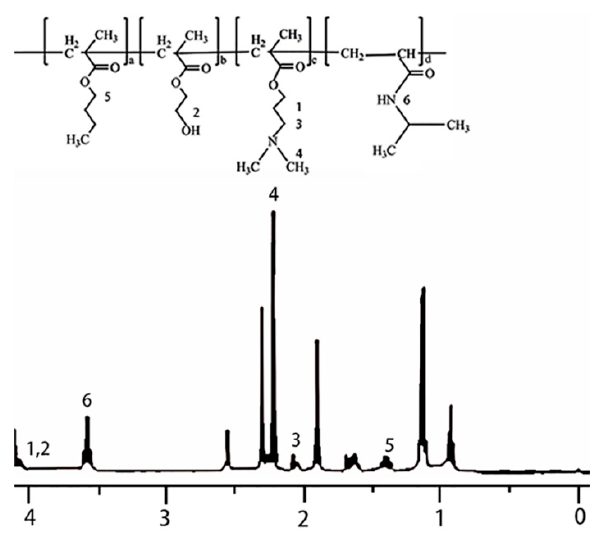
Figure 7. 1 H NMR spectrum of the temperature and the pH dual-responsive copolymer.